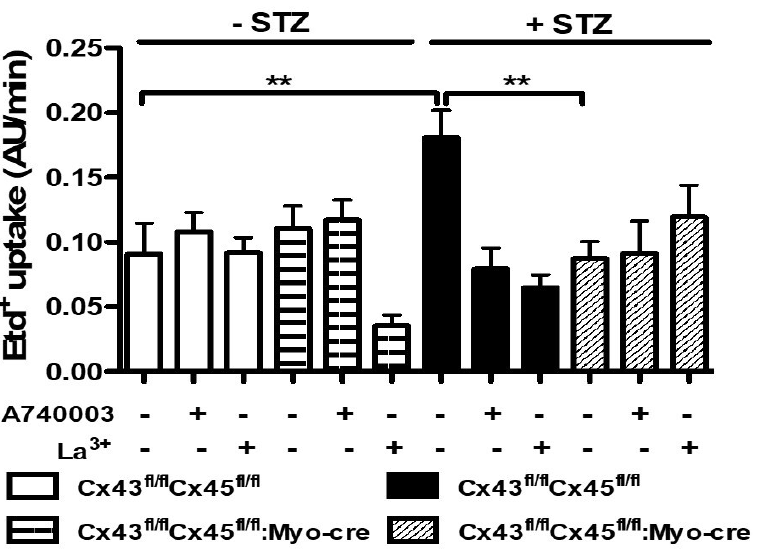
Figure 6. Lack of connexin43 and connexin45 expression prevents increased membrane permeability induced by diabetes in mice skeletal myofibers. Freshly isolated skeletal muscle fibers from flexor digitorum brevis muscles were isolated from control (Cx43 fl / fl Cx45 fl / fl ) and Cx43/Cx45 muscle-expression-de fi cient (Cx43 fl / fl Cx45 fl / fl : Myo-Cre) mice, which were treated with streptozotocin (+STZ) or not ( − STZ) to induce diabetes in these mice. The myo fi bers were used to measure membrane permeability by an ethidium (Etd + ) uptake assay. The graph shows the Etd + uptake rate obtained from slopes of fl uorescent intensity over time curves. The white bar represents myo fi bers from control mice without STZ treatment (Cx43 fl / fl Cx45 fl / fl ). The horizontal dashed bar represents myo fi bers from mice from which Cx43 and Cx45 genes were removed in early di ff erentiation stages with the Cre-LoxP method (Cx43 fl / fl Cx45 fl / fl : Myo-Cre). The black bar represents myo fi bers from control mice (Cx43 fl / fl Cx45 fl / fl ) treated with STZ, and the diagonal dashed bar represents myo fi bers from Cx43 fl / fl Cx45 fl / fl : Myo-Cre mice treated with STZ. Each bar represents the mean ± SE of n = 4 animals for each condition in independent experiments. ** p < 0.01. High glucose ‐ induced skeletal muscle fi ber permeabilization via membrane channels blocked by boldine